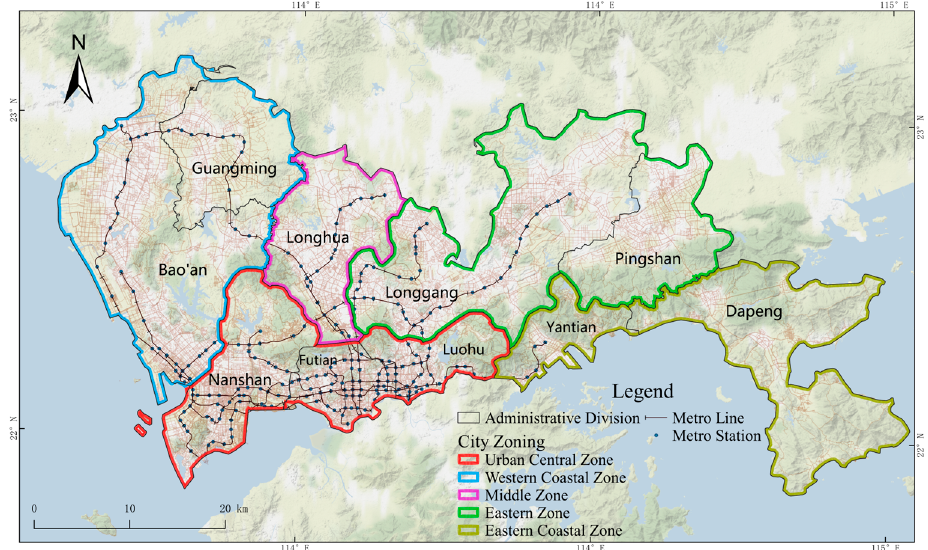
Figure 1. Distribution of study area and metro station